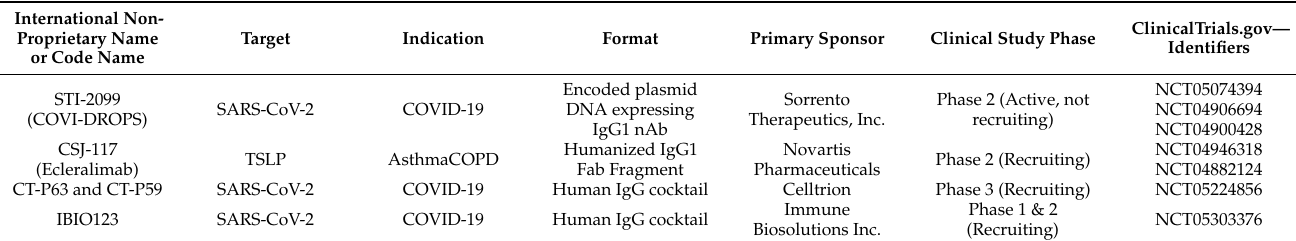
Table 6. Therapeutic antibodies in development delivered by intranasal/intratracheal administration, currently in phase 2 and phase 3 of clinical